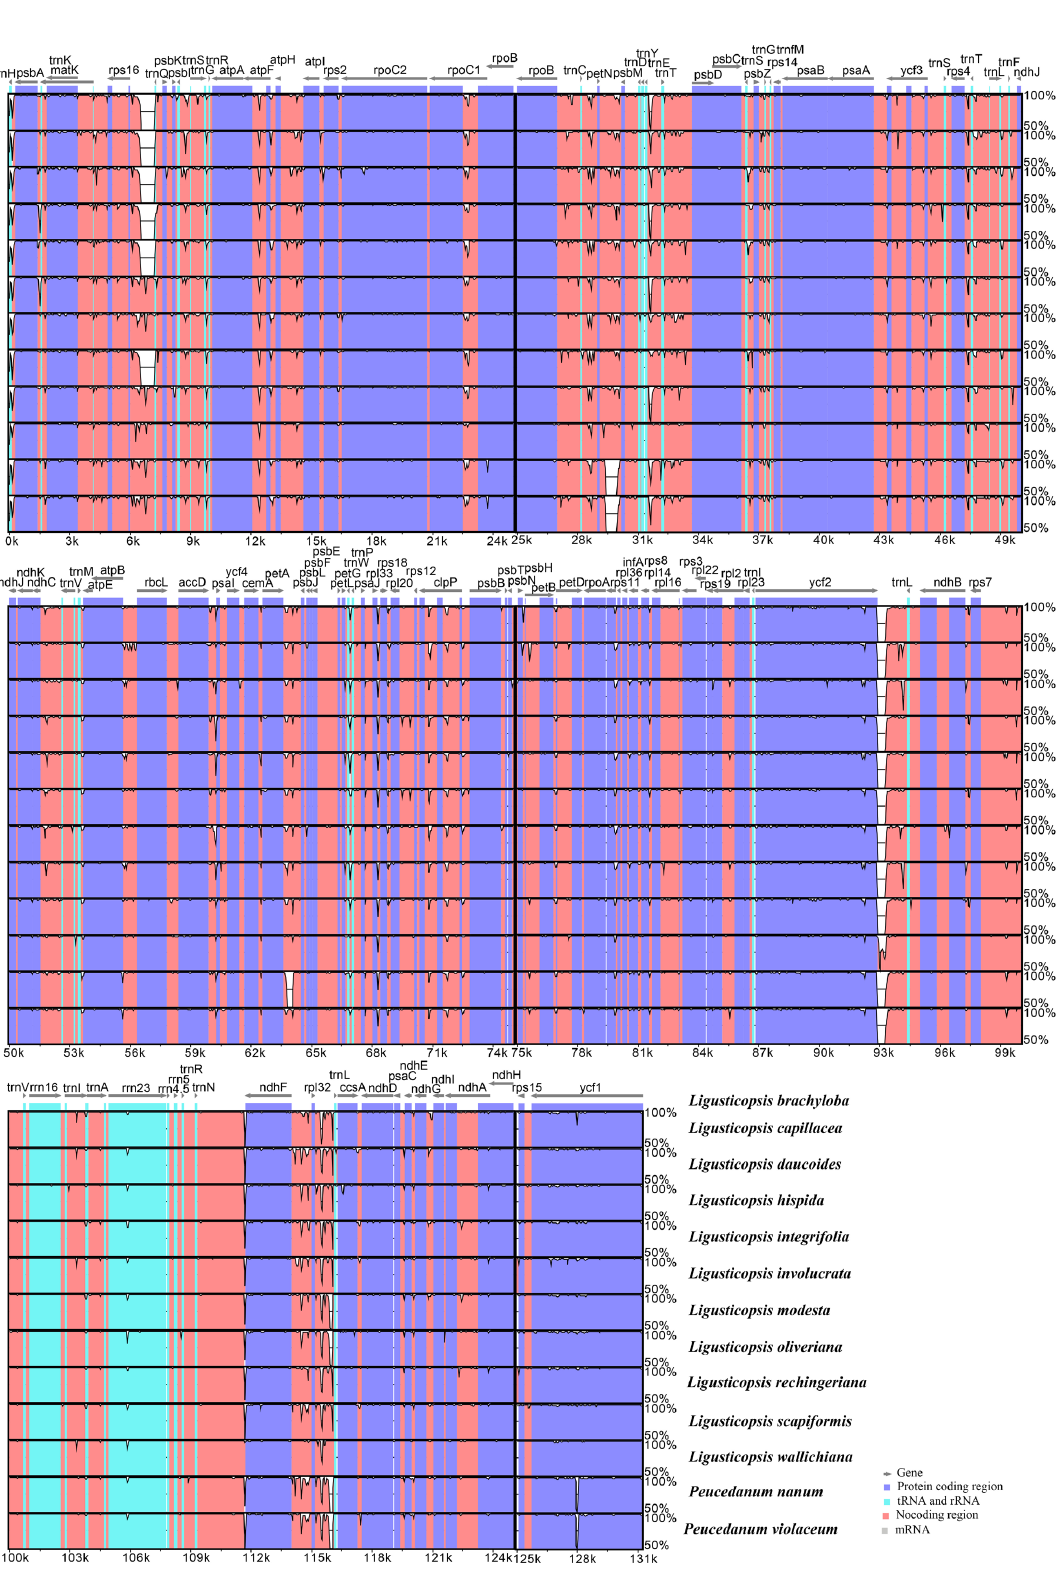
Figure 7. mVISTA alignment for thirteen plastomes.